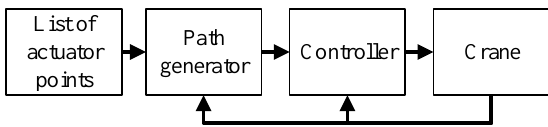
Figure 8. Point-to-point path controller